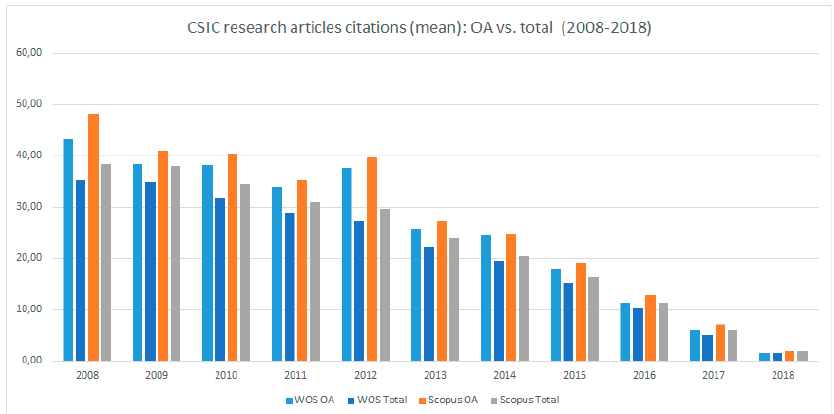
Figure 5. Graph with evolution of Open Access publishing at CSIC between 2008 and 2018.